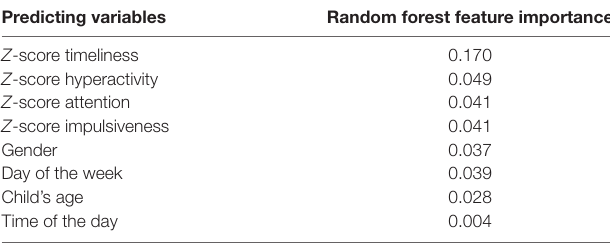
TABLE 2 | Random forest feature importance. Predicting variables Random forest feature